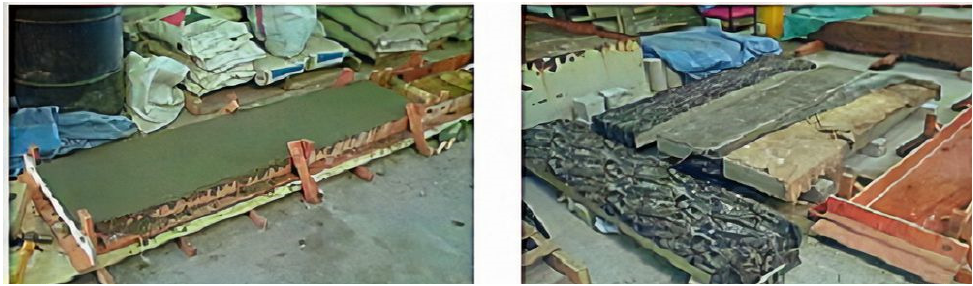
Figure 5. Schematic of casting and curing of the prepared slabs.